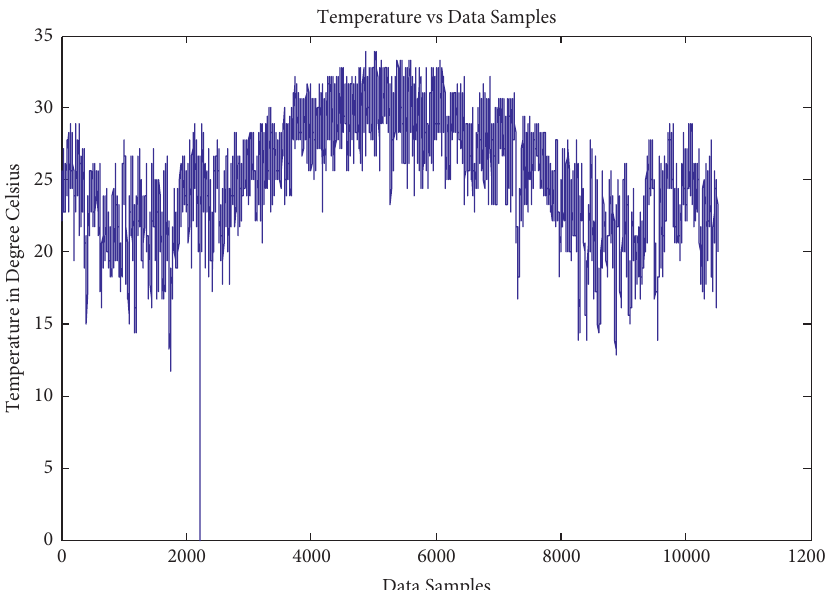
Figure 14: Temperature vs. data samples.